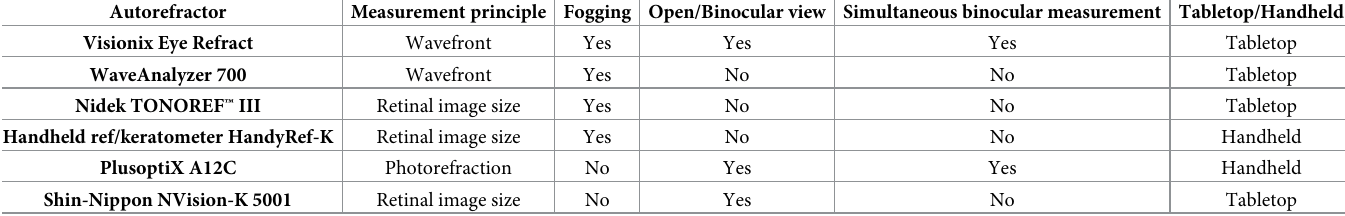
Table 1. Summary of the features of each autorefractor.